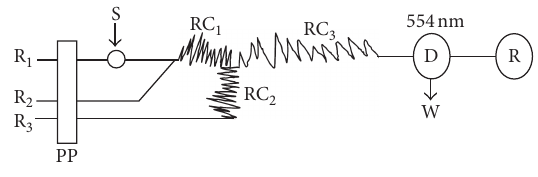
F 1: Proposed FI manifolds.